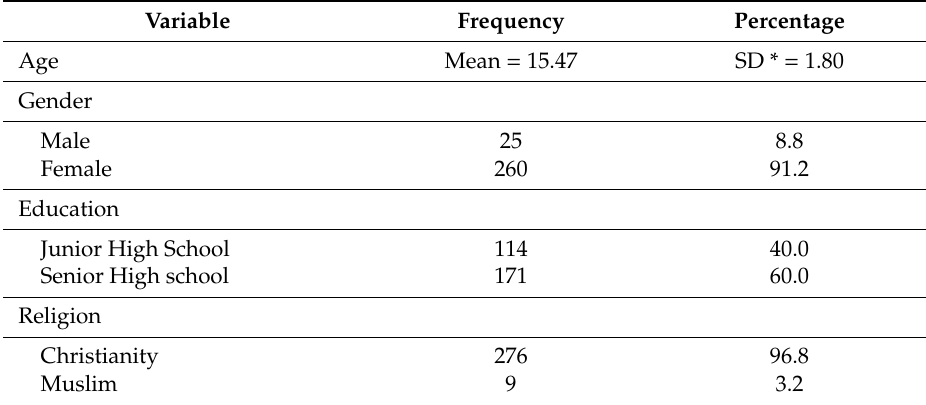
Table 1. Demographic characteristics and HPV related knowledge of the participants ( n =